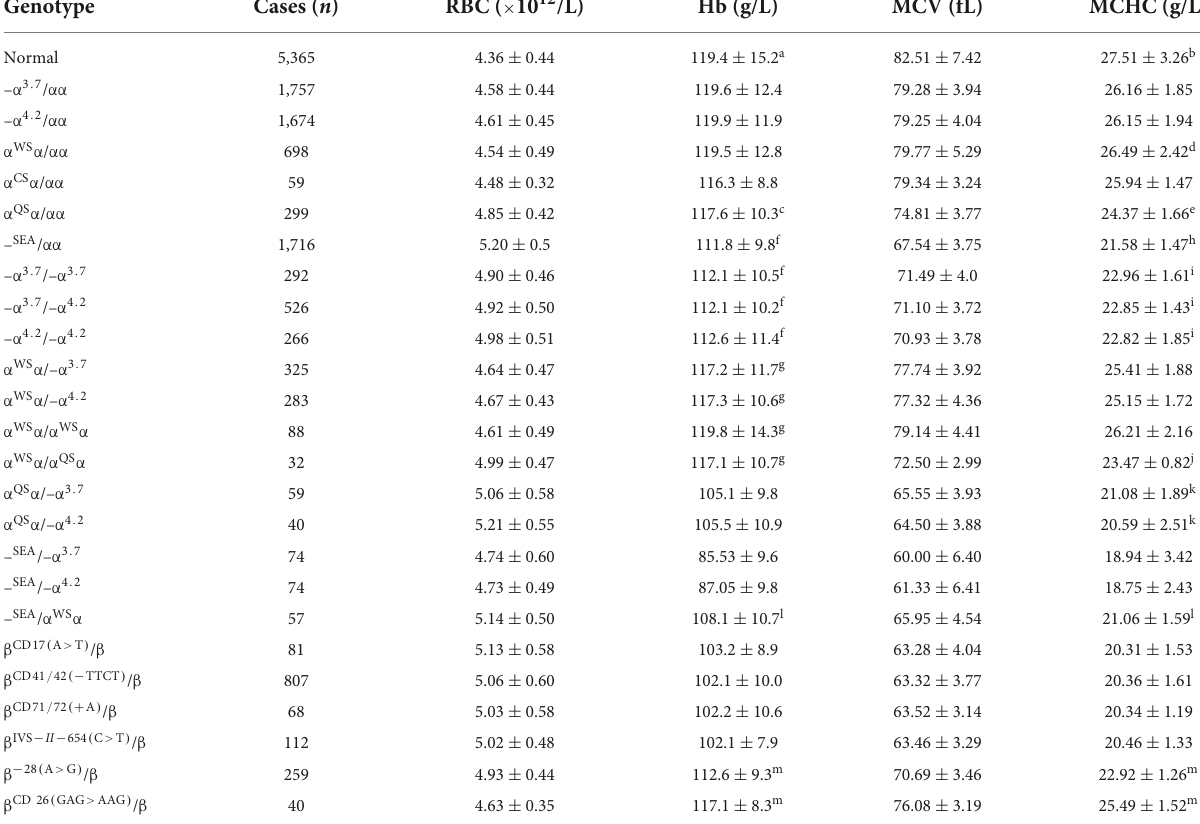
TABLE 1 The value of Hb and MCHC in PW with or without thalassemia genotypes.